Question: Summarize what this figure shows in one sentence.
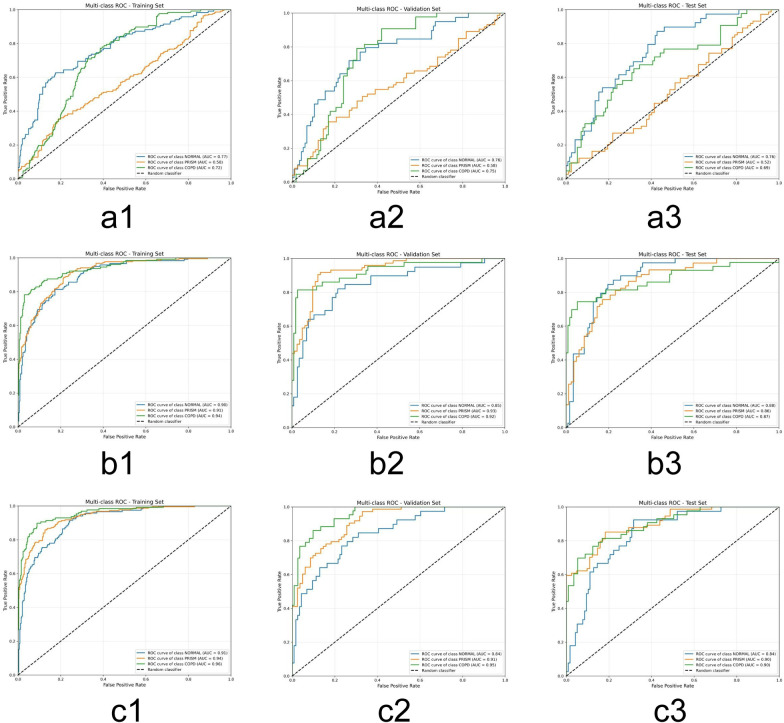
Answer: ROC curves for ablation experiments. (a1-a3) : M1: demographic – ROC curves for training (a1) , validation (a2) , and test (a3) sets. (b1-b3) : M2: CT imaging – ROC curves for training (b1) , validation (b2) , and test (b3) sets. (c1-c3) : M3: demographic+CT imaging – ROC curves for training (c1) , validation (c2) , and test (c3) sets. Each subplot displays three class-specific ROC curves: normal (blue solid line), PRISm (red solid line), and COPD (green solid line), with their corresponding AUC values annotated in the legend. The diagonal black dashed line represents the random classifier baseline (AUC = 0.5). PRISm, preserved ratio impaired spirometry; COPD, chronic obstructive pulmonary disease; AUC, area under the curve; NPV, negative predictive value; PPV, positive predictive value.